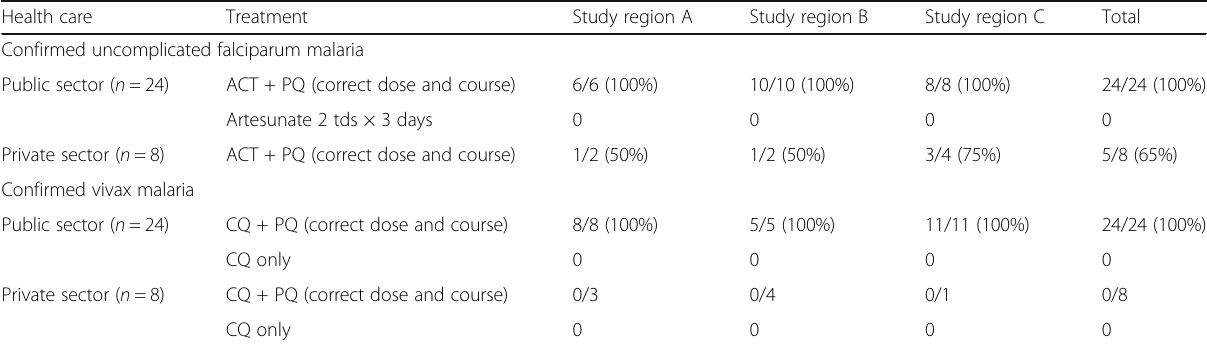
Table 1 Reported antimalarial treatment practices of health care providers in six study sites of three states/regions, Myanmar ( n = 32) Health care